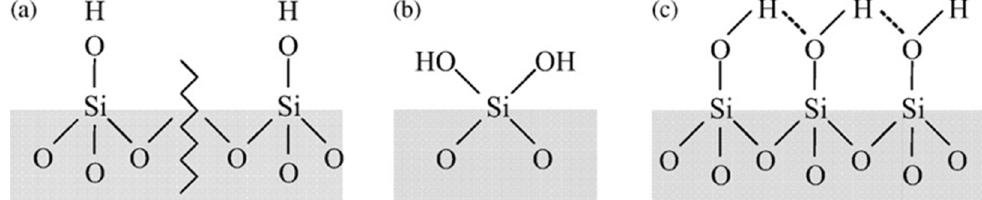
Figure 4. Schema of the silanol groups on the surface, ( a ) isolated, ( b ) geminal, and ( c ) vicinal.